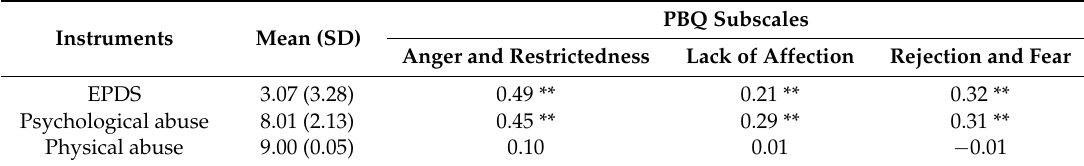
Table 4. Correlations between each factor of the PBQ and other scale